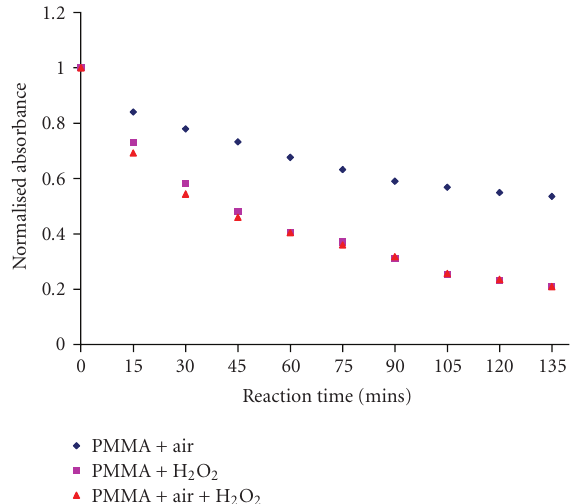
Figure 7: E ff ect of bubbling air and adding hydrogen peroxide on the destruction rate of produced water with the plate reactor.